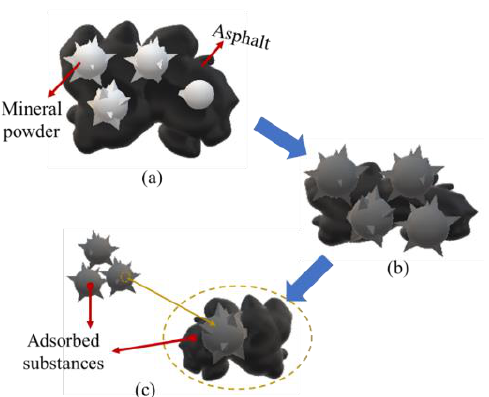
Figure 5. Adsorption mechanism for mineral powder: ( a ) adsorption; ( b ) adhesion; ( c ) sediment